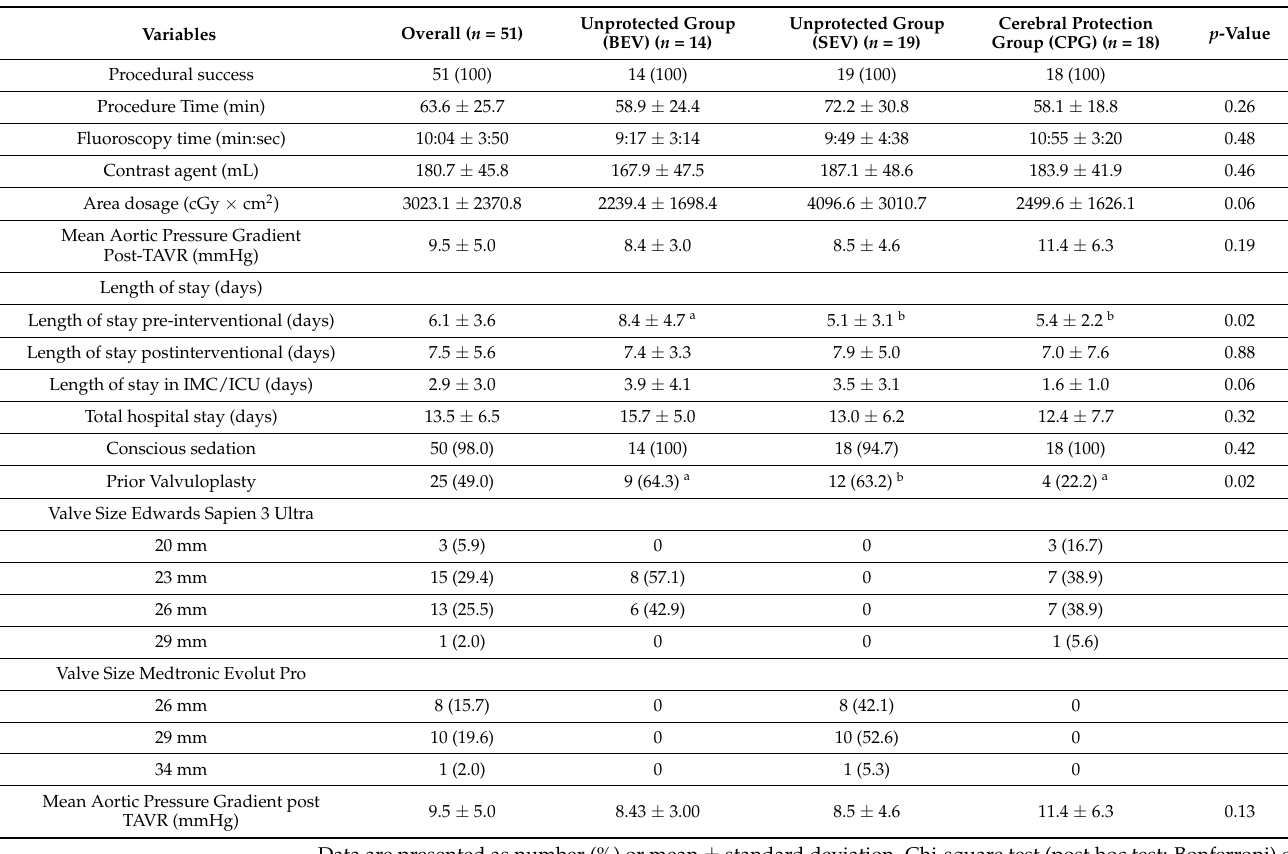
Table 2. Procedural Details.